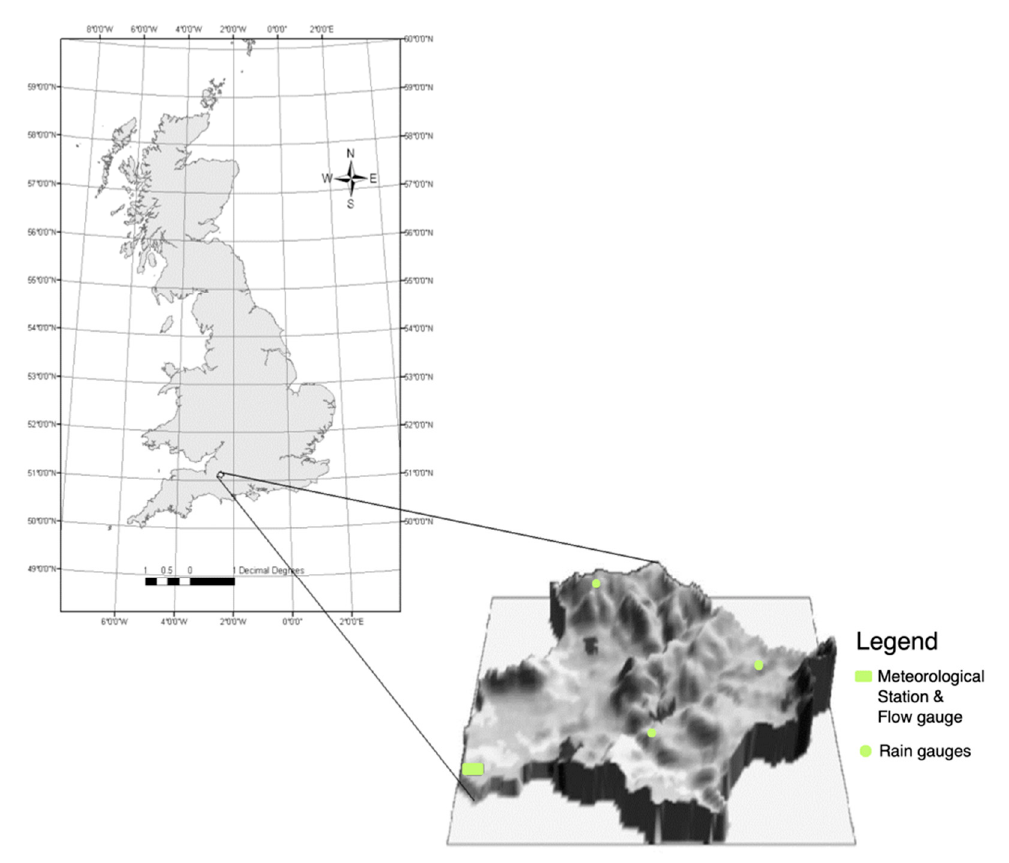
Figure 1. Geographical location of the study area.